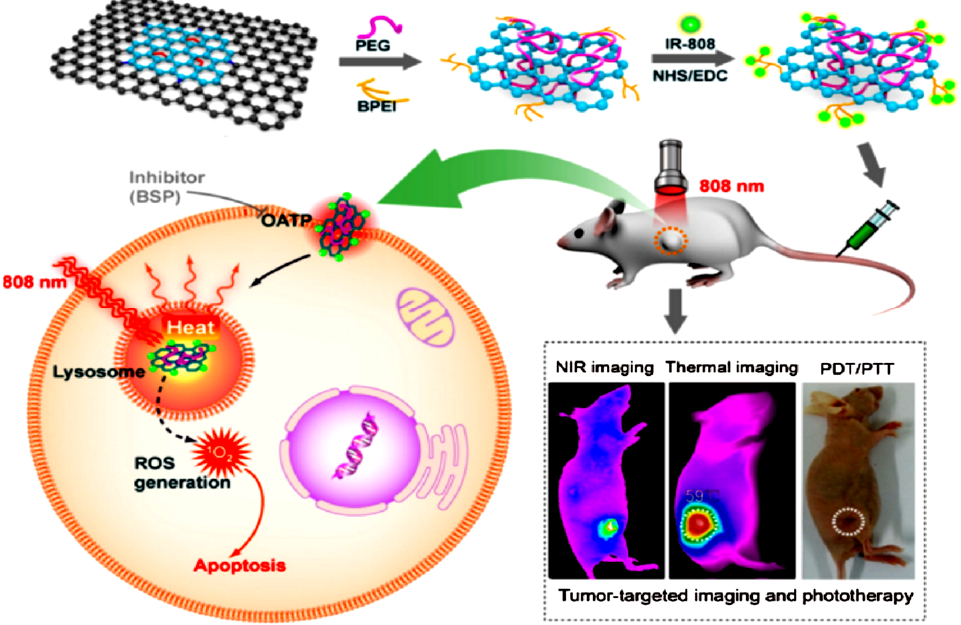
Figure 4. Schematic illustration of NGO-808 preparation and combined A549 tumor xenografts-targeted NIR imaging and synergistic phototherapy (PDT and PTT [74,75] Reprinted with permission from Elsevier.